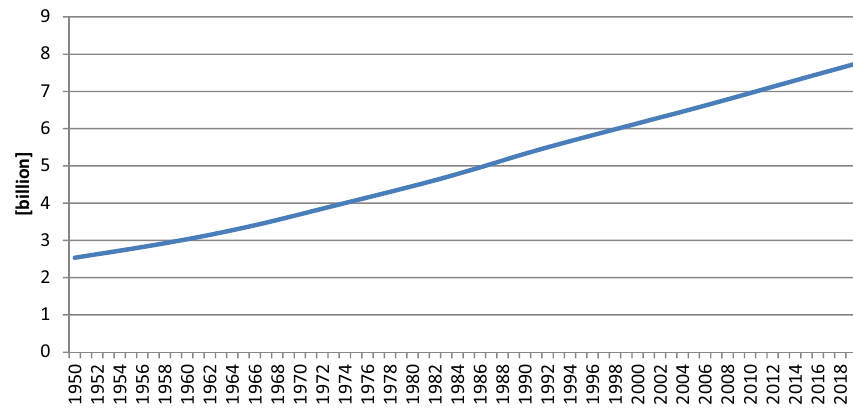
Figure 2: World population between 1950 and 2020. Source: own work based on ref. [ 4 ] . Note: as of 1 July